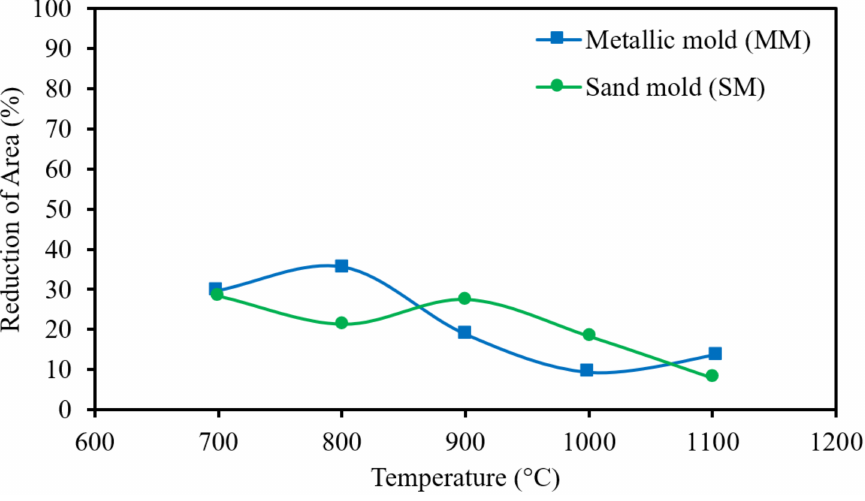
Figure 16. Hot ductility curves for a TWIP steel having the composition 0.45% C, 22% Mn, 1.5% Al and 1.5% Si with 0.02% Ti for two different cooling rates, the tensile specimens were cast in metallic and sand molds